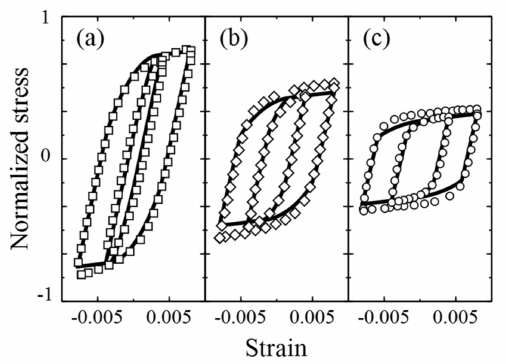
Figure 9. Comparison between experiment (empty symbols) and simulated (solid curve) cyclic stress–strain response obtained for three aging conditions of AlSi7Cu0.5Mg0.3 alloy with a unique identification for our model. Stresses are normalized for confidentiality